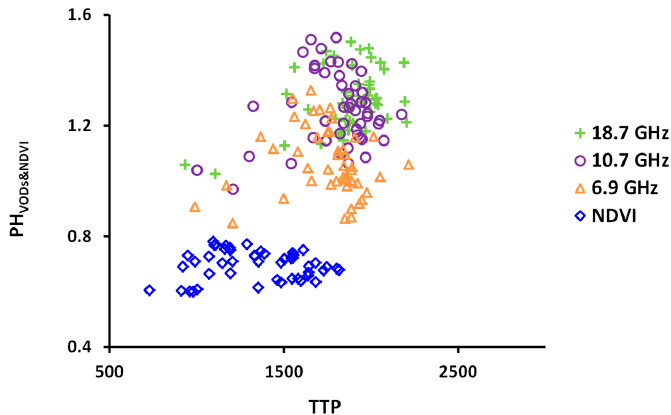
( b ) Figure 9. Annual phenometrics of NAHT as a function of PH NDVI : ( a ) for all study sites; and ( b ) selected study sites for 2003–2010. Sites are numbered according to their latitudinal position from south (1) to north (50) (Figure 1). 3.2.2. The Maximum Value Approach for VOD Phenometrics For the land surface phenology of VOD, Figure 10 presents the PH VOD as a function of the corresponding TTP VOD for all sites. In the study sites dominated by croplands, PH VOD ranged between 0.85 and 1.74, while the PH NDVI (also calculated using the maximum value approach) ranged between 0.60 and 0.83. The ordering of the PH VOD magnitude from high to low was 18.7 GHz > 10.65 GHz > 6.925 GHz: the higher the frequency, the higher the attenuation by vegetation, and, thus, the larger the VOD magnitude. The PH VOD lags the PH NDVI , because the PH VOD responds to vegetation water